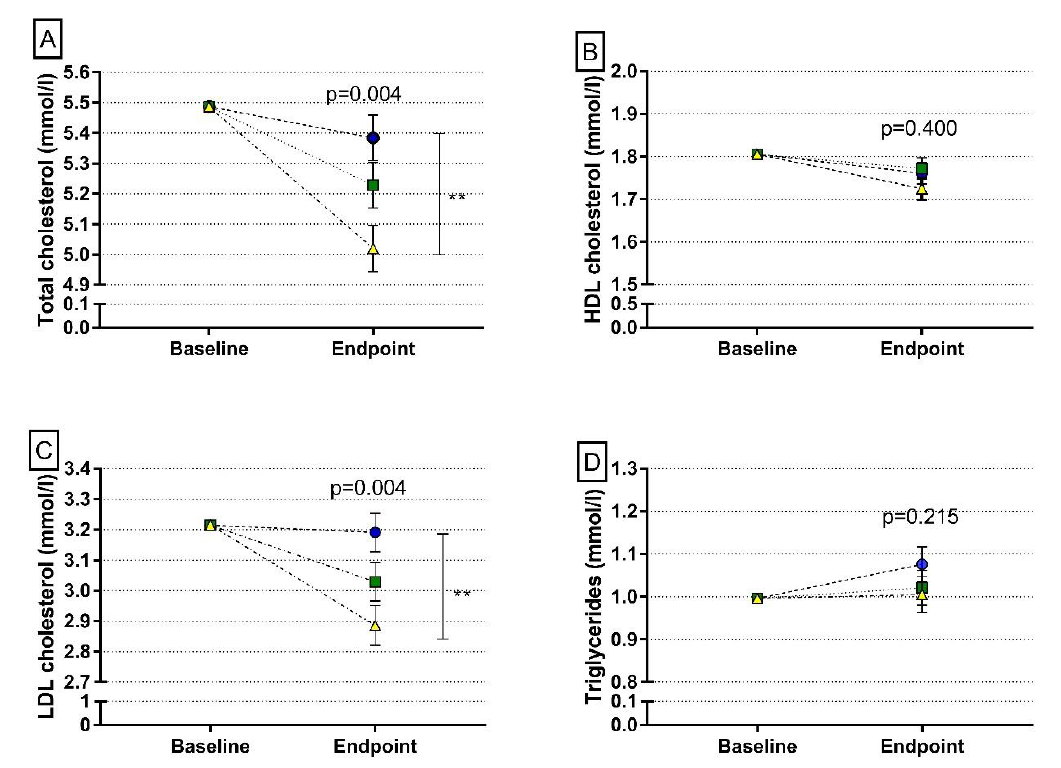
Figure 3. Plasma lipids at the endpoint of the intervention: ( A ) total cholesterol ( B ) high-density lipoprotein (HDL) cholesterol, ( C ) low-density lipoprotein (LDL) cholesterol, ( D ) triglycerides. Symbols: BLUE circle = ANIMAL (a diet containing 70% animal-based and 30% plant-based protein sources of total protein intake); GREEN square = 50 / 50 (a diet containing 50% animal-based protein sources and 50% plant-based protein sources of total protein intake); YELLOW triangle = PLANT (a diet containing 70% plant-based and 30% animal-based protein sources of total protein intake); ** p < 0.01 between a diet containing 70% plant-based protein sources of total protein and a diet containing 70% animal-based protein sources of total protein. p values from ANCOVA, adjusted for baseline, Bonferroni correction used for group comparison.